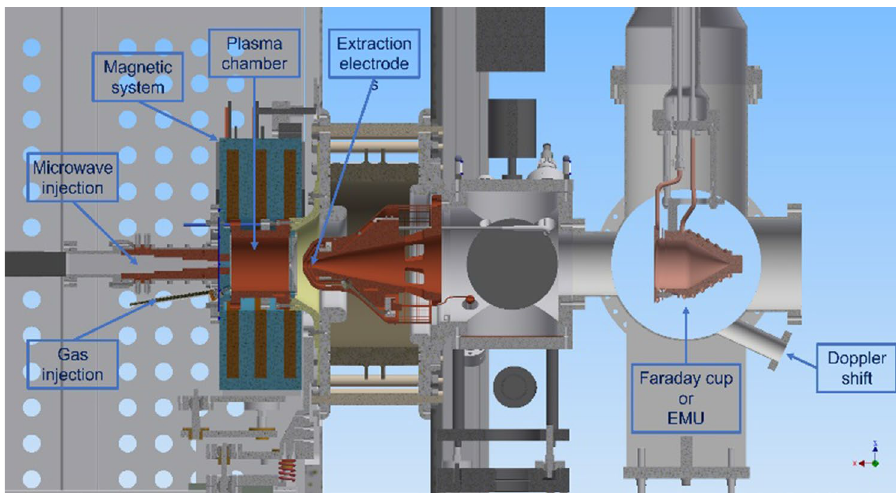
Figure 1. A half sectional view of the source and the first part of the LEBT (picture generated with Autodesk-